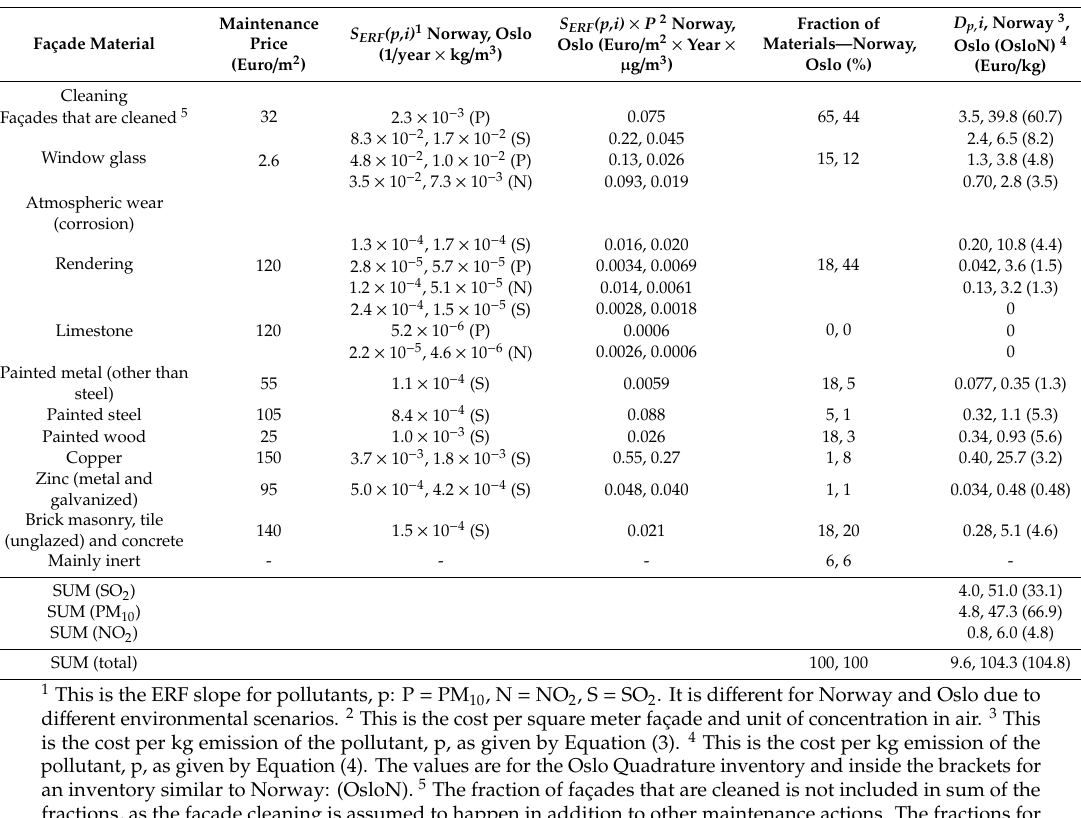
Table 5. E ff ect slopes, S ERF (p,i), and marginal damage cost, S ERF (p,i) × P and D p,i , due to atmospheric wear of façade materials from air pollution in Norway and Oslo. The maintenance costs and fractions of materials for Norway and Oslo are given, from Table 4, to facilitate the reading of the